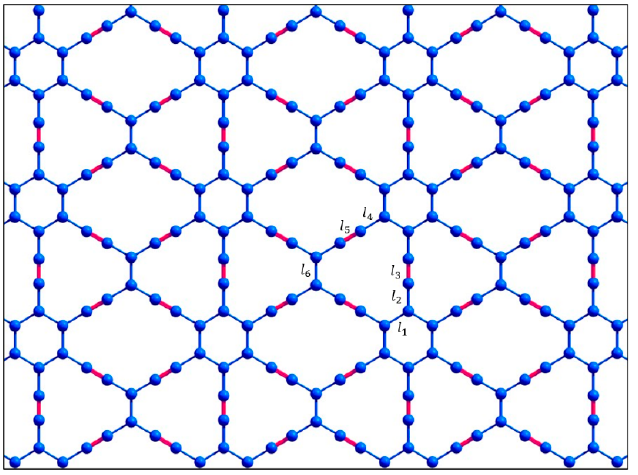
Figure 3. Atomic structure of the two-dimensional 6,6,12-graphyne sheet.